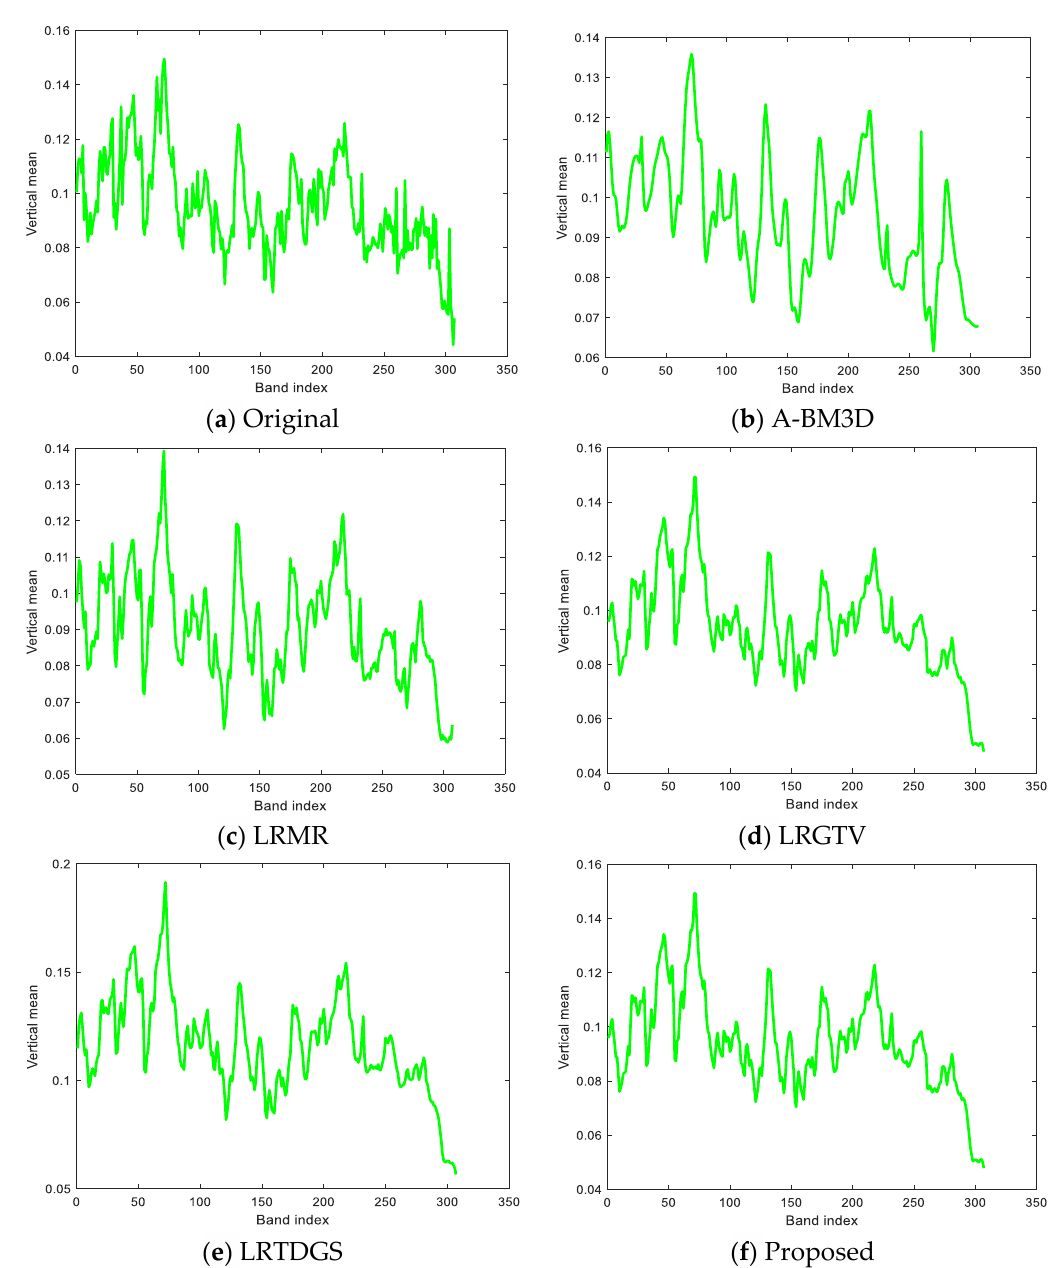
Figure 12. The vertical mean profiles of band 205 on a real urban image.